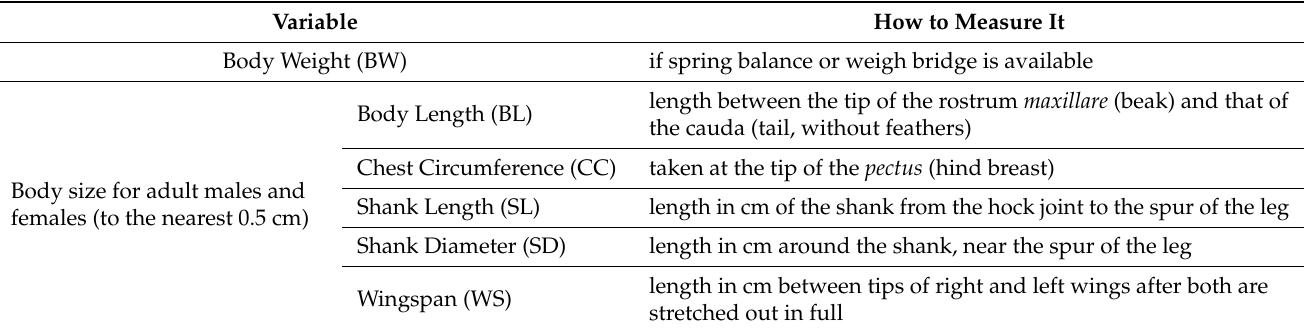
Table 1. Biometric variables and measuring procedure to obtain them from the animals. Variable How to Measure It Body Weight (BW)